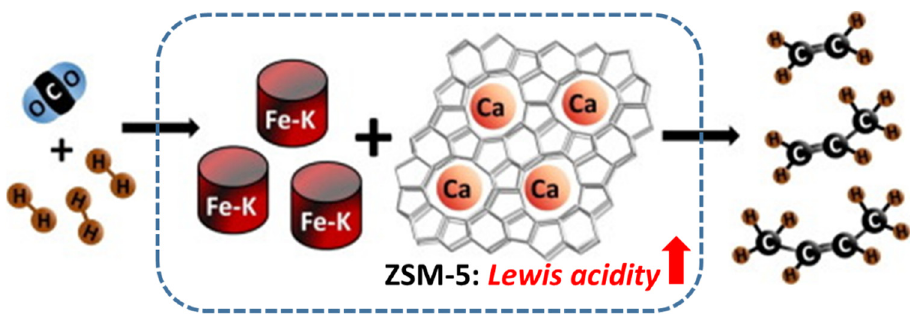
Figure 14. Visualization of the light olefin formation via CO 2 hydrogenation over K-promoted iron catalyst supported on ZSM-5 zeolite modified with Ca. Adapted from [108] with copyright license from Elsevier (2021).